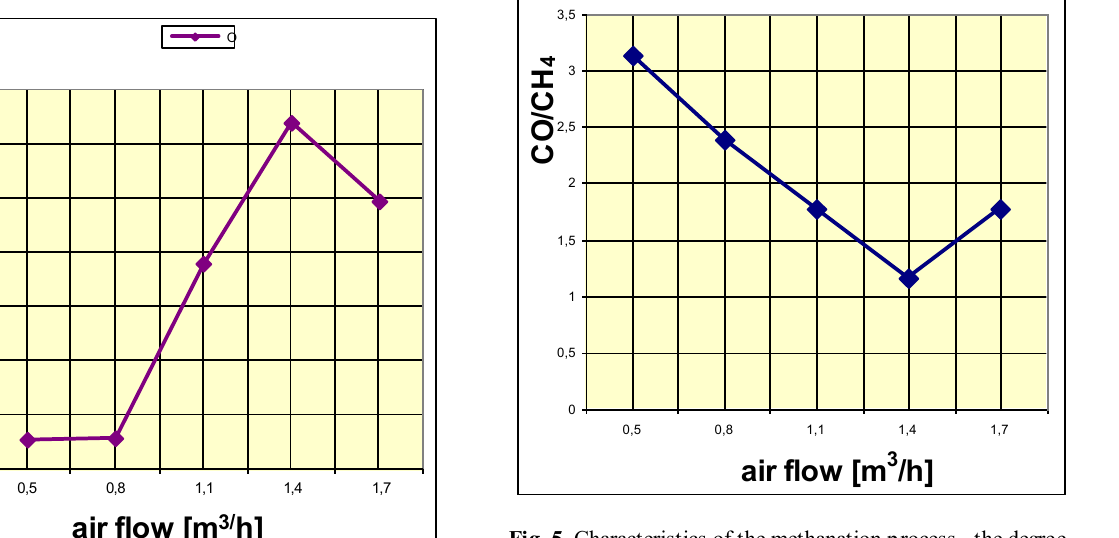
Fig. 5 . Characteristics of the methanation process - the degree of conversion of CO to CH 4.